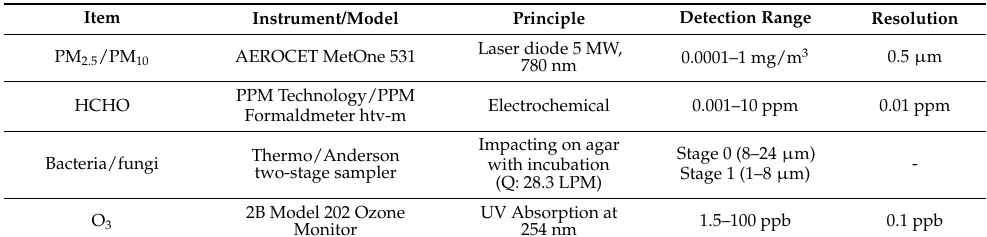
Table 1. Details of instruments for indoor air quality